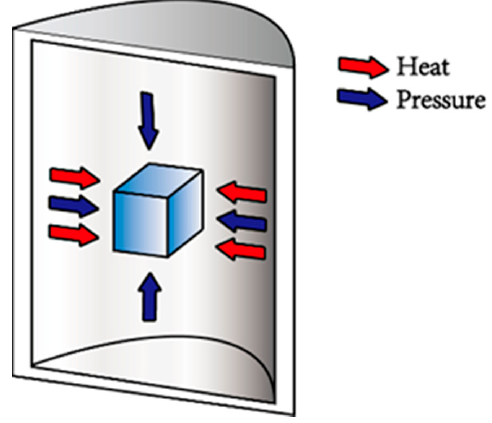
Figure 33. Schematic diagram of the HIP [23]. HIP is necessary post-processing for AM mirror blanks. Figure 34 presents a compar- ison of Songnian Tan’s product before and after HIP. The porosity of the mirror blanks reduced from 0.092% to 0.005% [37]. The result of the study showed that in the following HIP treatment, the internal pores were reduced, and the tensile strength was reduced due to the microstructure changes. It further illustrated the feasibility of HIP in